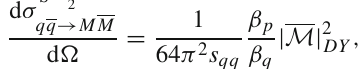
, 2 . The corre- 3 3